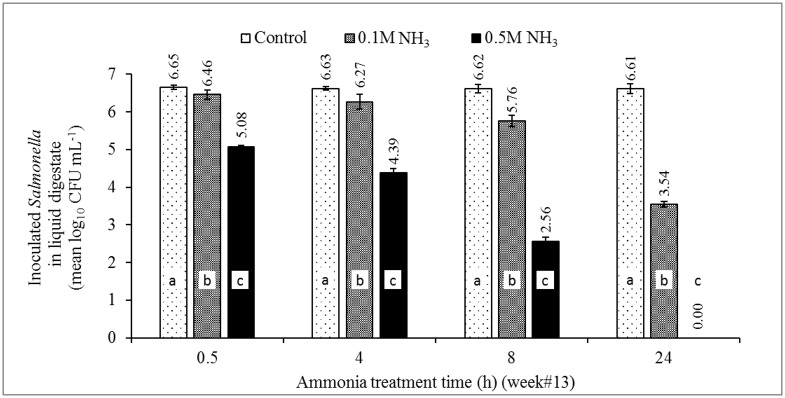
The effect of MIC of ammonia (0.105 and 0.524 M NH3; the equivalent of 1,468 and 7,340 NH3-N mg/L) on the survival of newly seeded ST4232 in digestate of week #13 poultry carcass aerobic digestion.Source of NH3 was (NH4)2SO4. The control contained only residual TAN (0.00057 M) in the digestate collected at week #13 [24]. Week #13 represents a late-phase of a complete aerobic digestion represented by lower microbial activity post the 99% reduction of BOD, TSS, and VSS. Data represents the mean log10 of measured Salmonella concentrations of 4 aerobic reactors ± SD. Different letters in each treatment time indicate significant difference (p<0.05), n = 3.